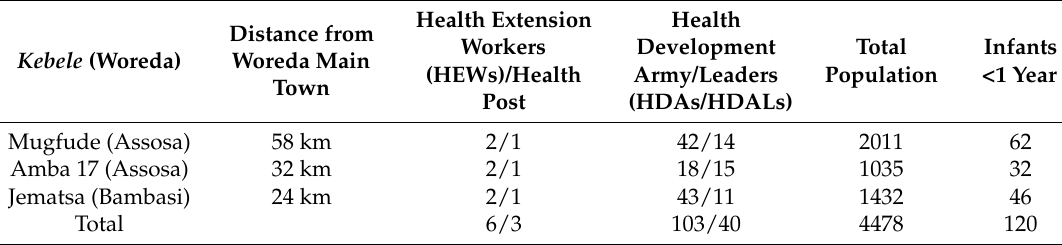
Table 1. Composition of selected study